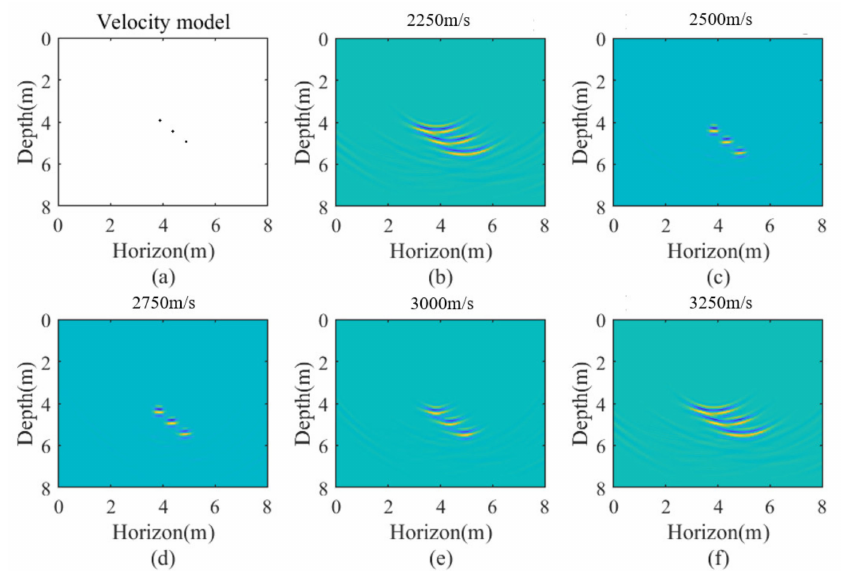
Figure 23. Imaging results using different background velocities while the true velocity is 3000 m/s. ( a ) True velocity model; ( b ) 2250 m/s; ( c ) 2500 m/s; ( d ) 2750 m/s; ( e ) 3000 m/s; ( f ) 3250